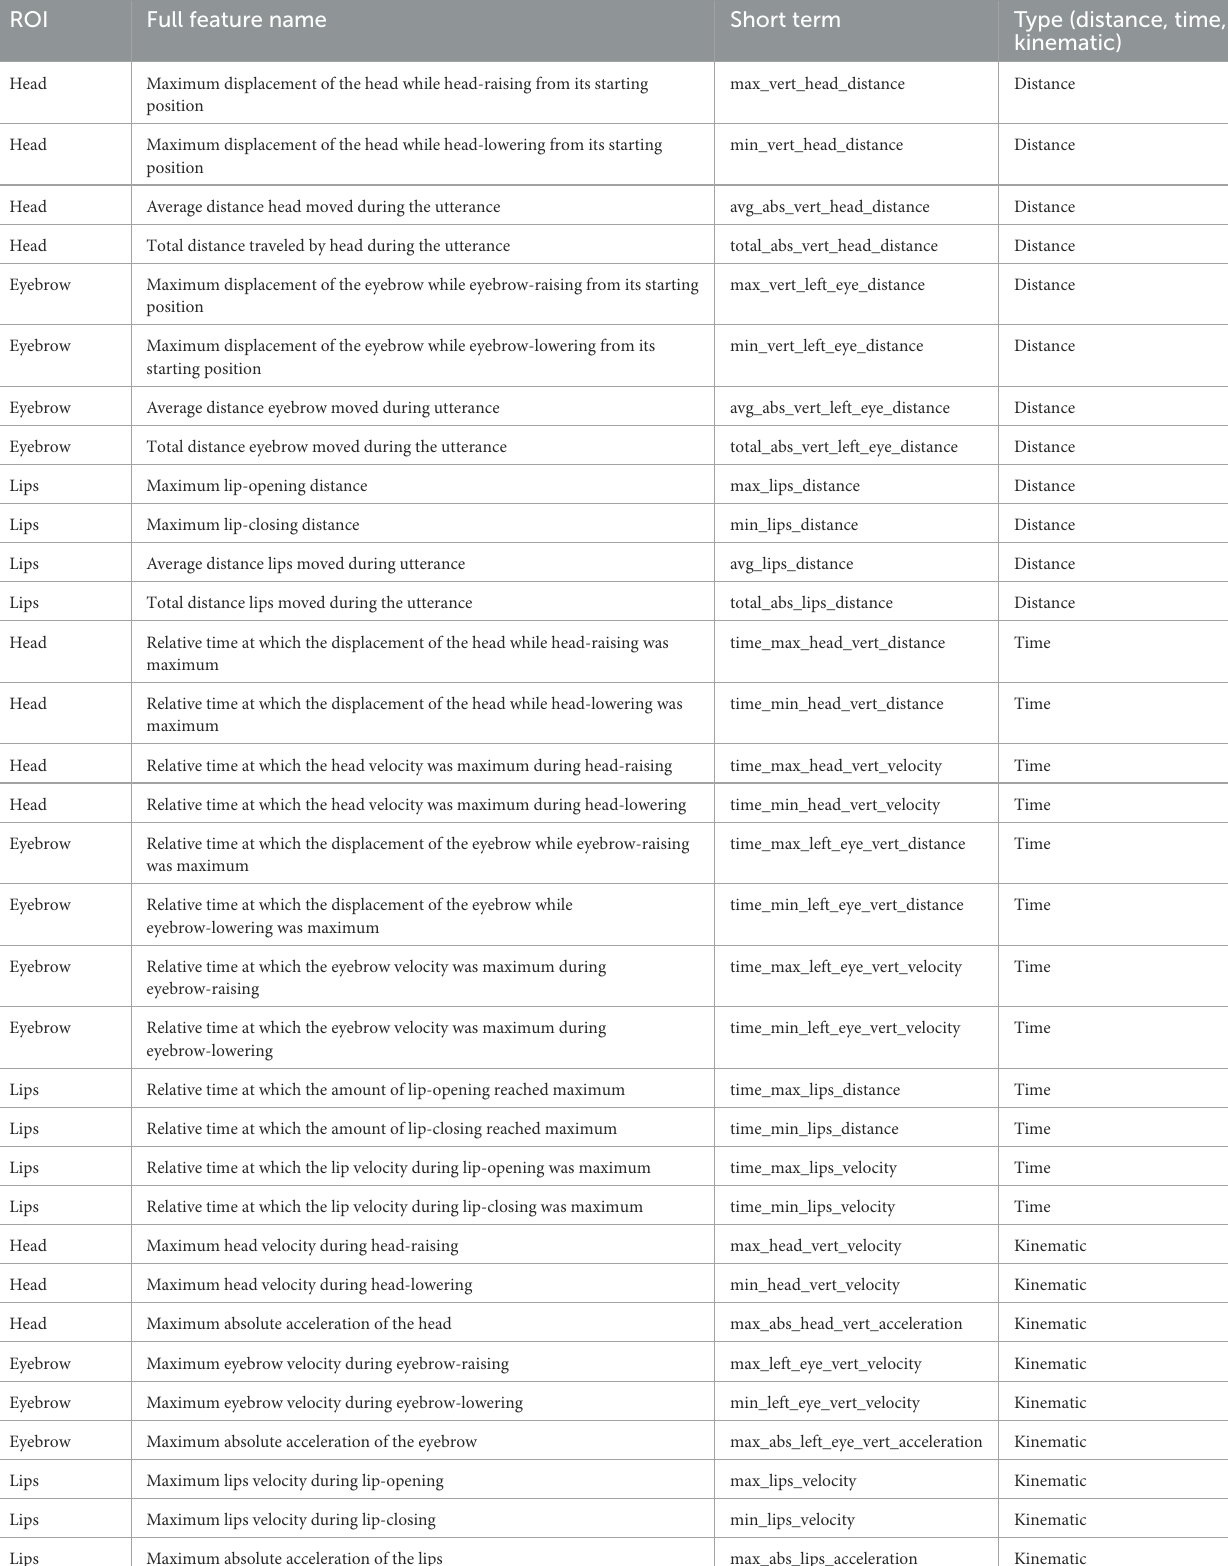
TABLE 1 The set of 33 features used to represent tone articulation in each video token (cf. Garg et al., 2019). ROI Full feature name Short